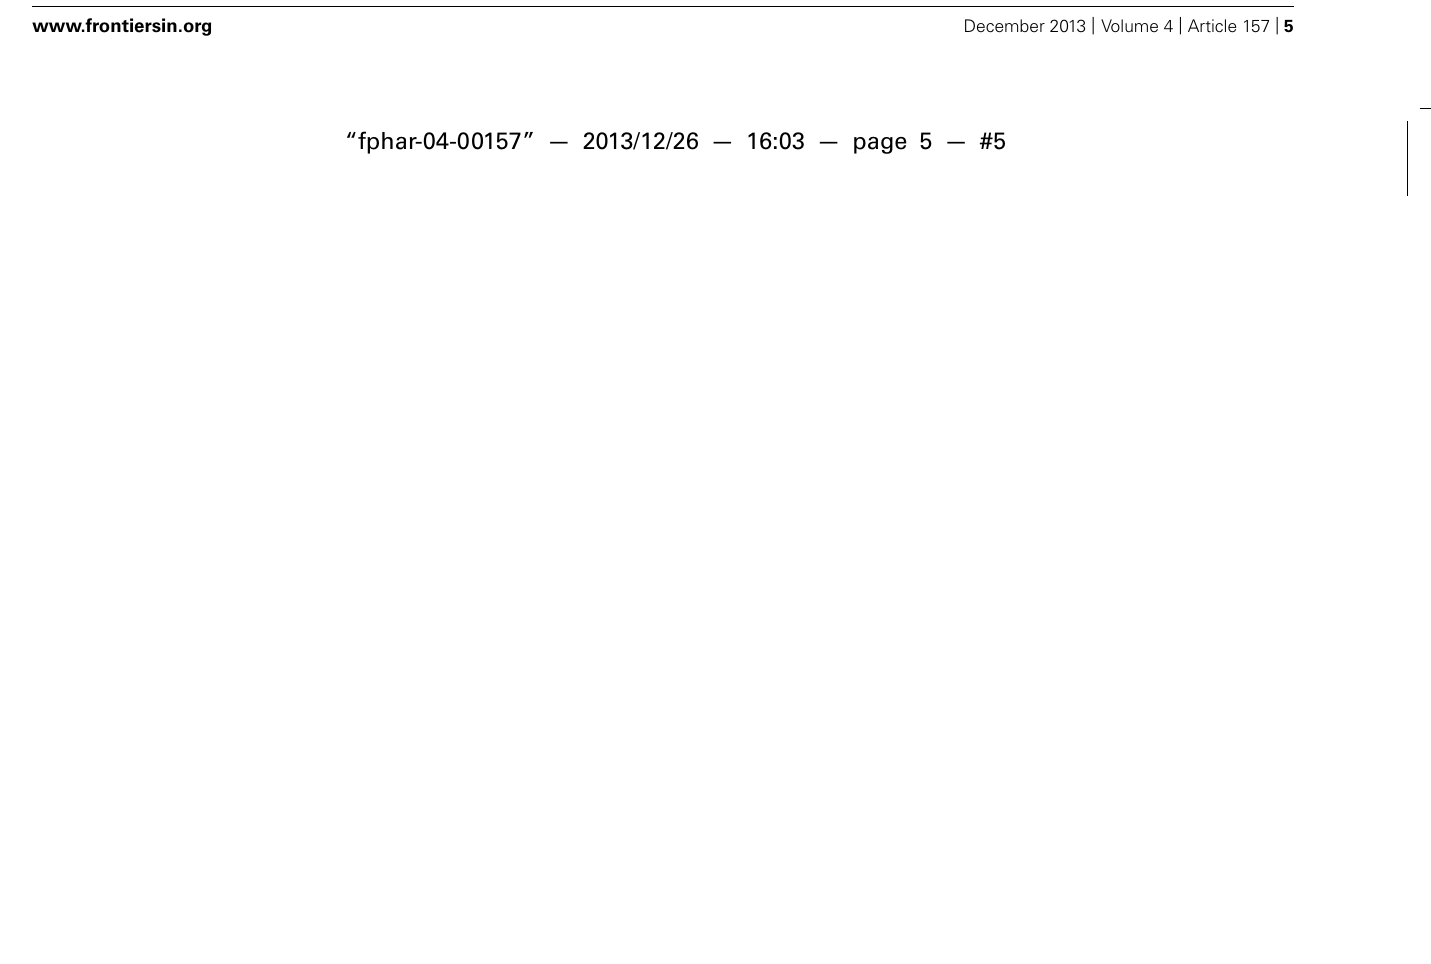
FIGURE 1 | Comparison of NK012 micelle formulation with bevacizumab and CPT-11 therapy. Athymic mice were injected intracranially with Luciferase-labeled U87MG and treated starting 8 days after tumor cell implantation. NK012 was delivered at 30 mg/kg intravenously three times